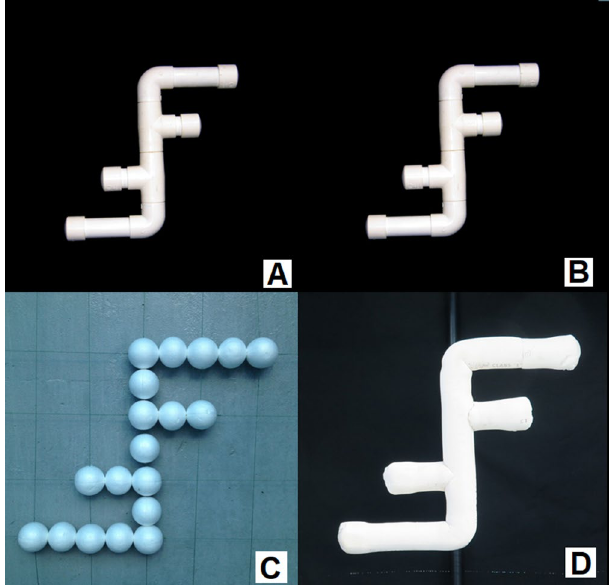
Figure 5. Examples of sample objects, FF-shape, with different material compositions. ( A ) The air-filled PVC pipe object. ( B ) The water-filled PVC pipe object. ( C ) The foam ball array object. ( D ) The soft closed-cell foam- wrapped PVC pipe object. The objects used in the experiments were constructed in four types of shape and made of four materials. They are all shown in Fig. 4C, from left to right: OP-shape, DL-shape, SQ-shape, and FF-shape. More details about objects’ shapes and names for each case are provided in Supplementary Figure